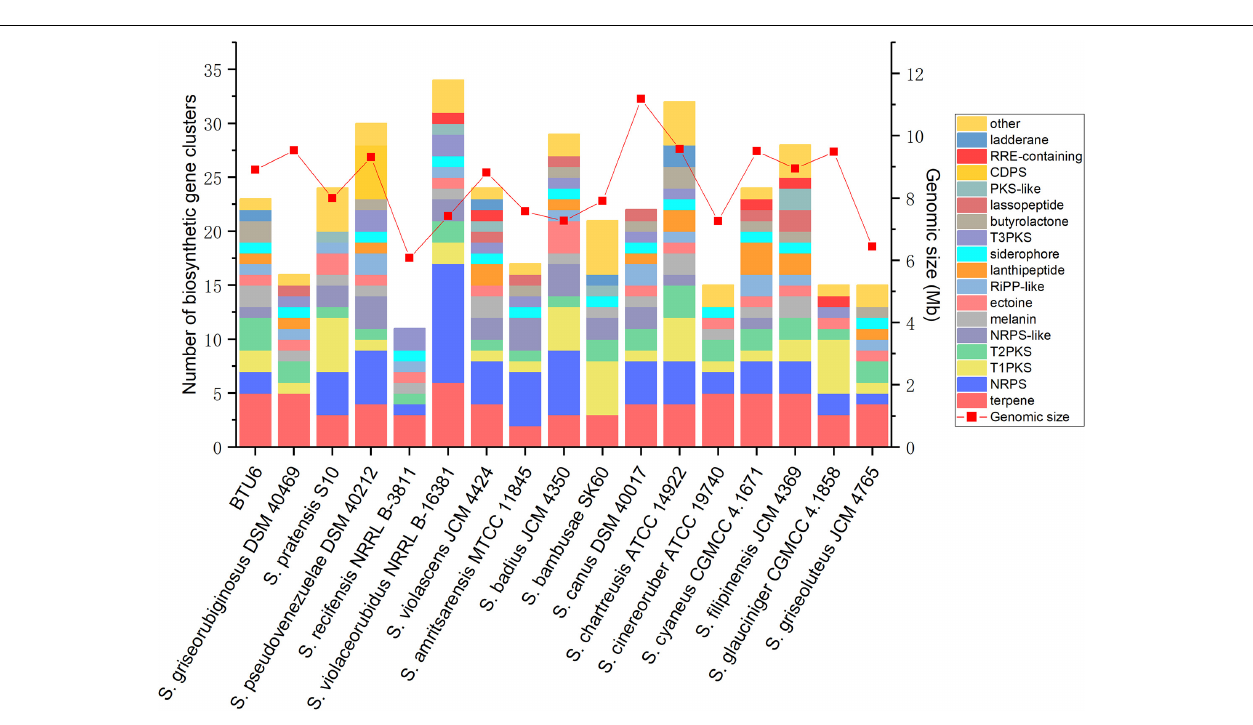
FIGURE 5 | Comparison of 17 Streptomyces biosynthetic gene clusters and genome size, with similarity ≥